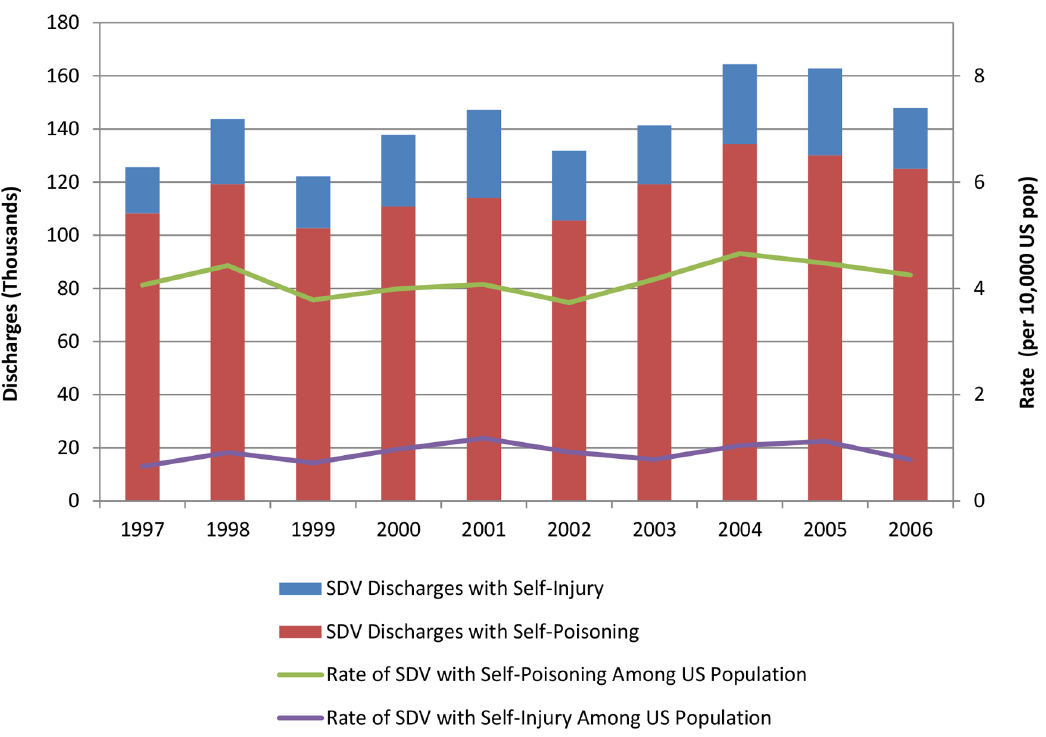
Figure 1. Counts and rates of self-directed injury and self-directed poisoning 1997–2006. SDV; self-directed violence.